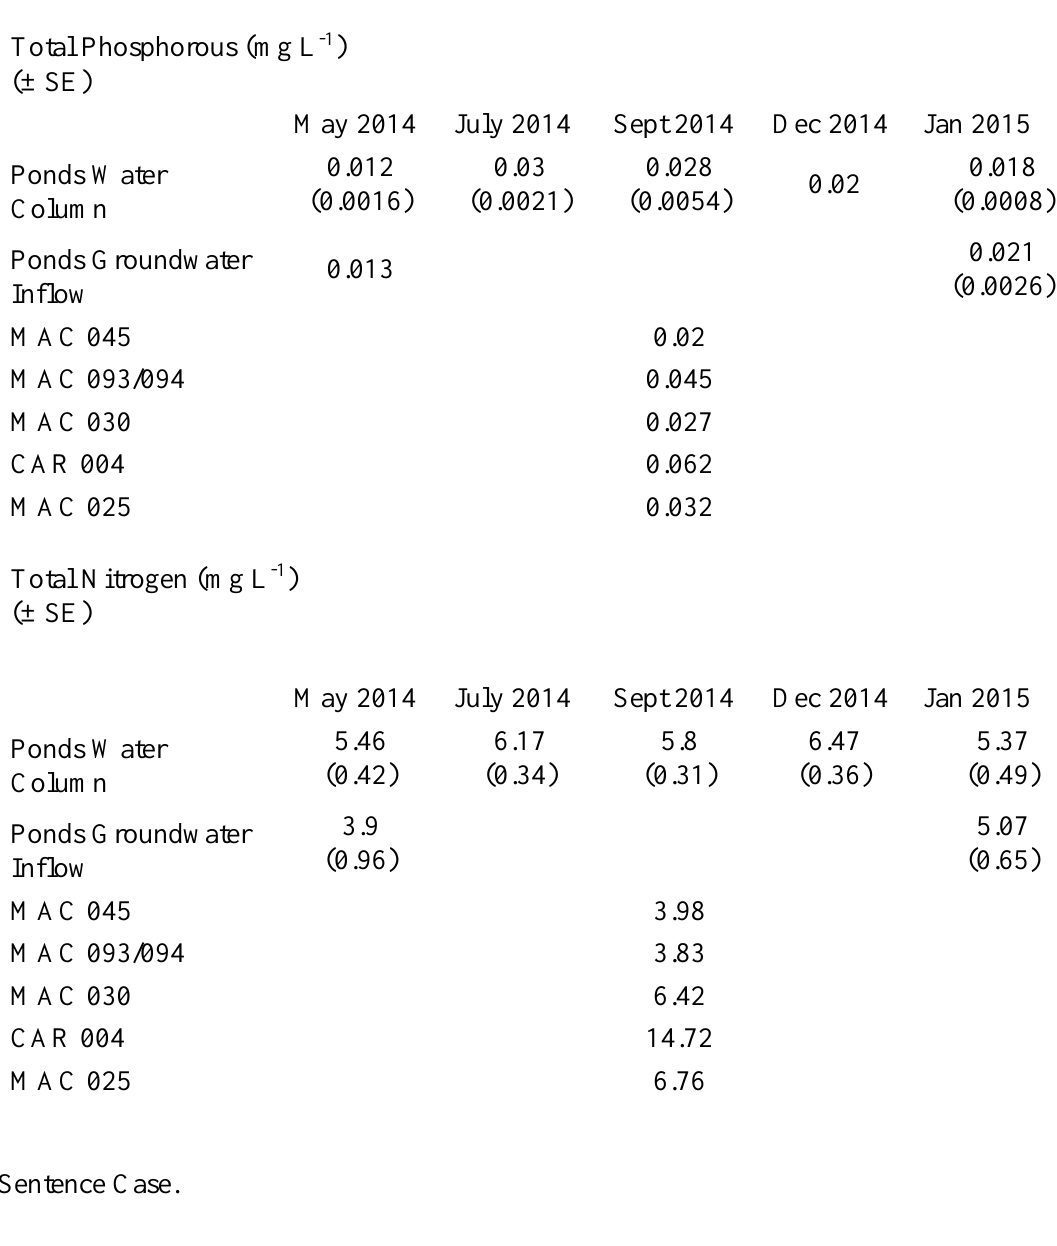
Table A2.1. Raw nutrient data collected in Ewens Ponds water column, groundwater